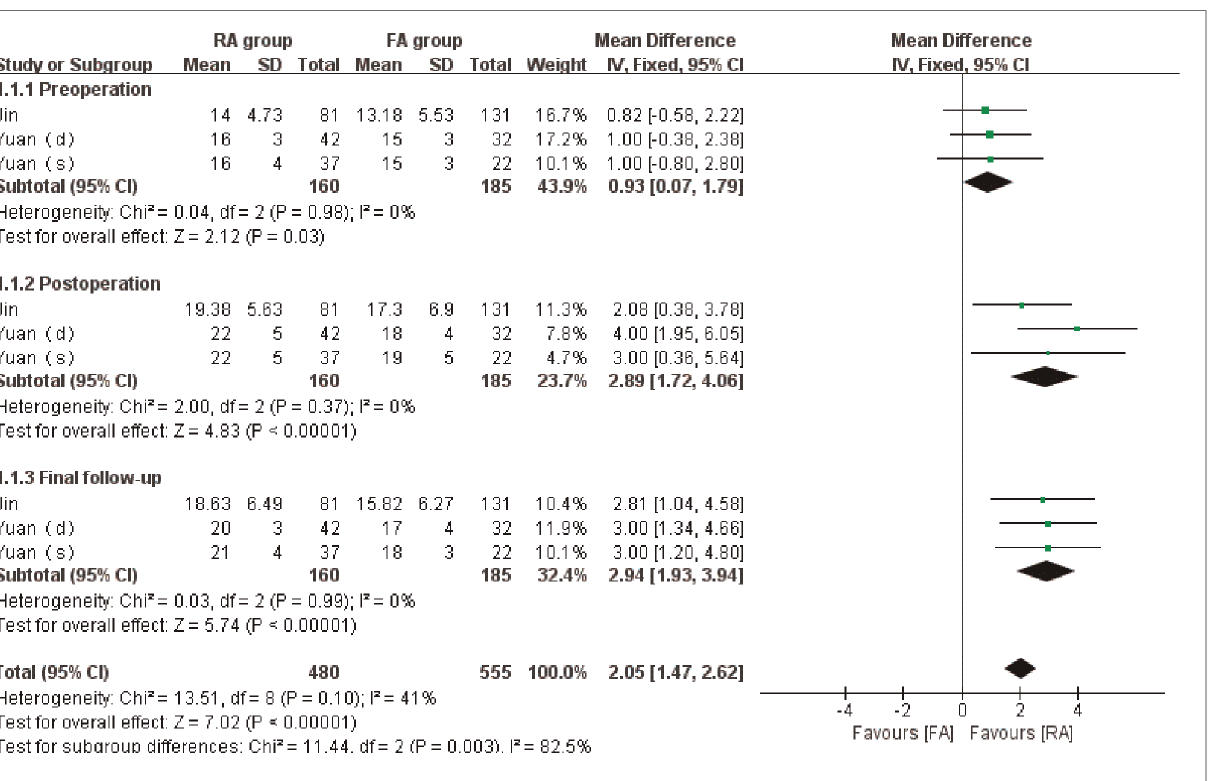
FIGURE 2 | Forest plot depicting WMDs of the vertebral